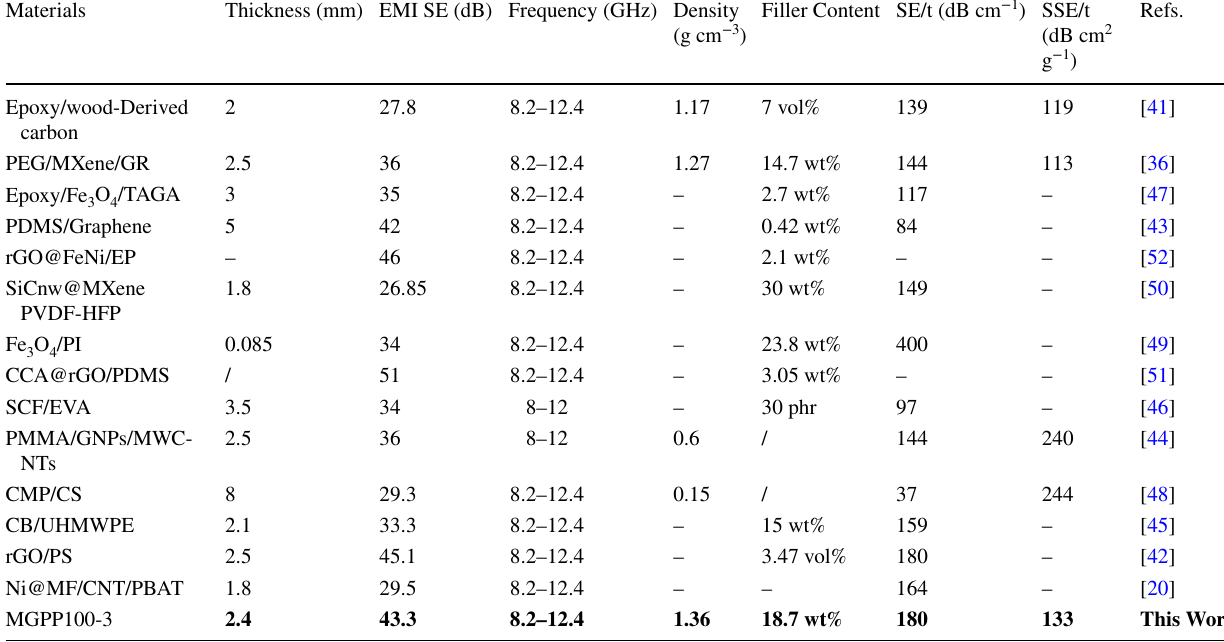
Table 1 Comparison of EMI shielding of polymer matrix composites